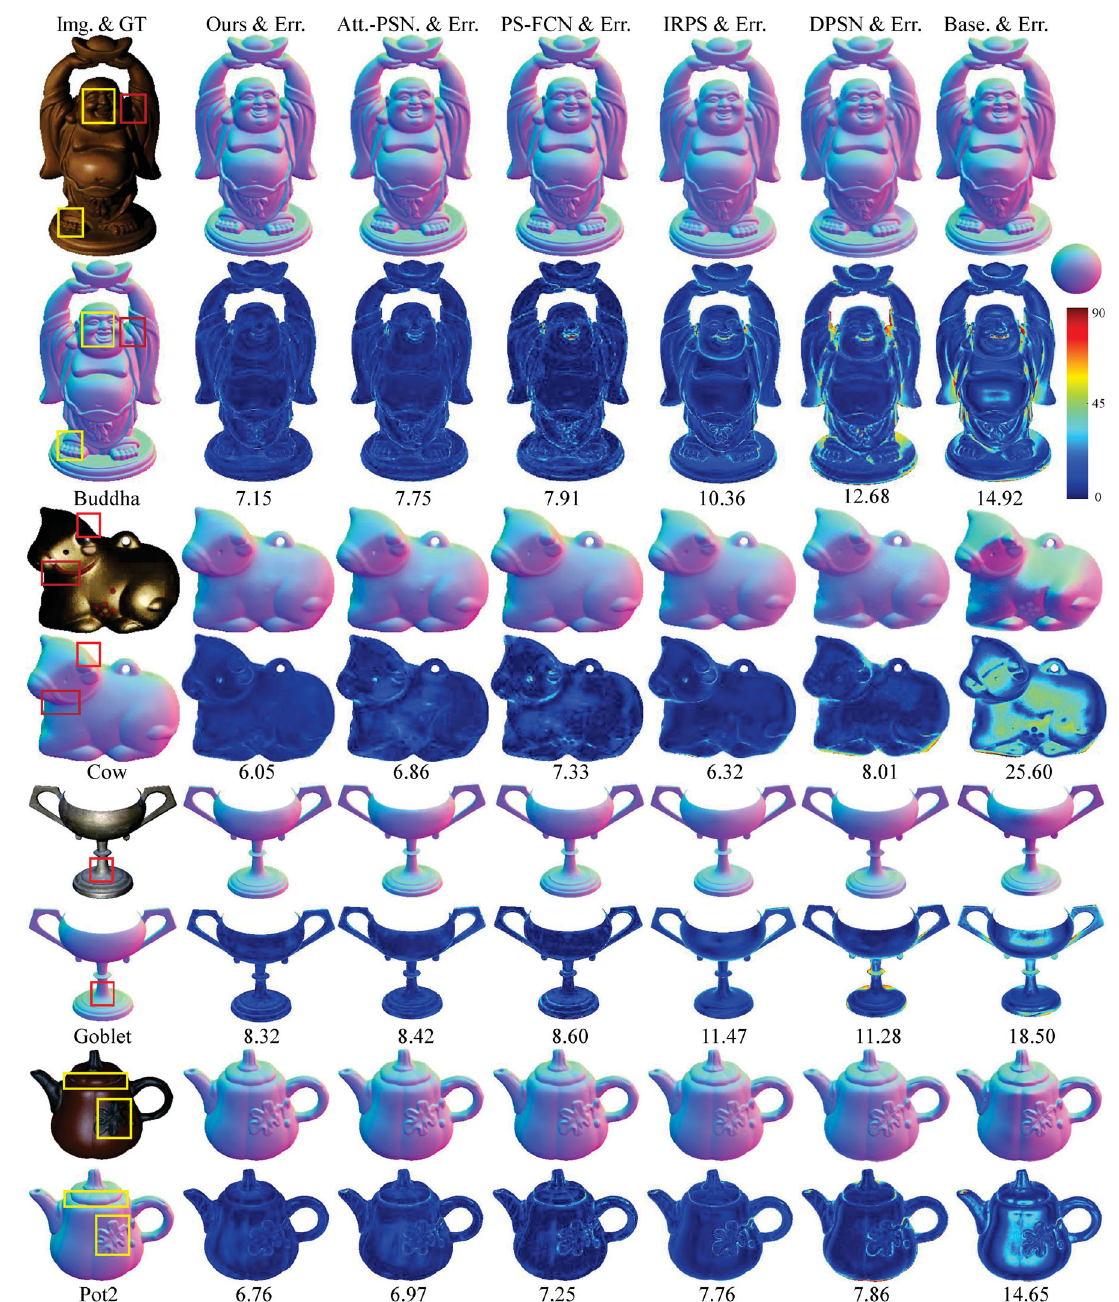
Fig. 3 Comparison using Buddha, Cow, Goblet, and Pot2 from the DiLiGenT benchmark. Yellow boxes: regions with high-frequency surfaces (such as crinkles). Red boxes: regions with cast shadows. Att.-PSN: Attention-PSN [37]. Base.: Baseline least squares method [2]. Contrast is adjusted for ease of